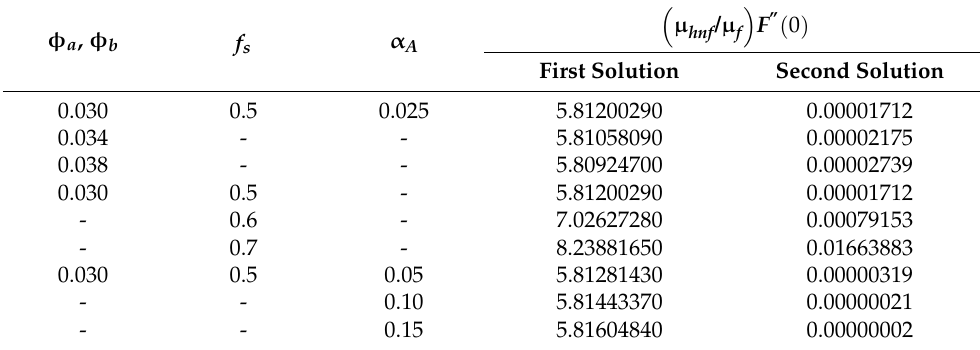
Table 4. Computational data of the Nusselt number for the numerous choice of the dissimilar comprised parameters when λ = –0.75 and Pr =